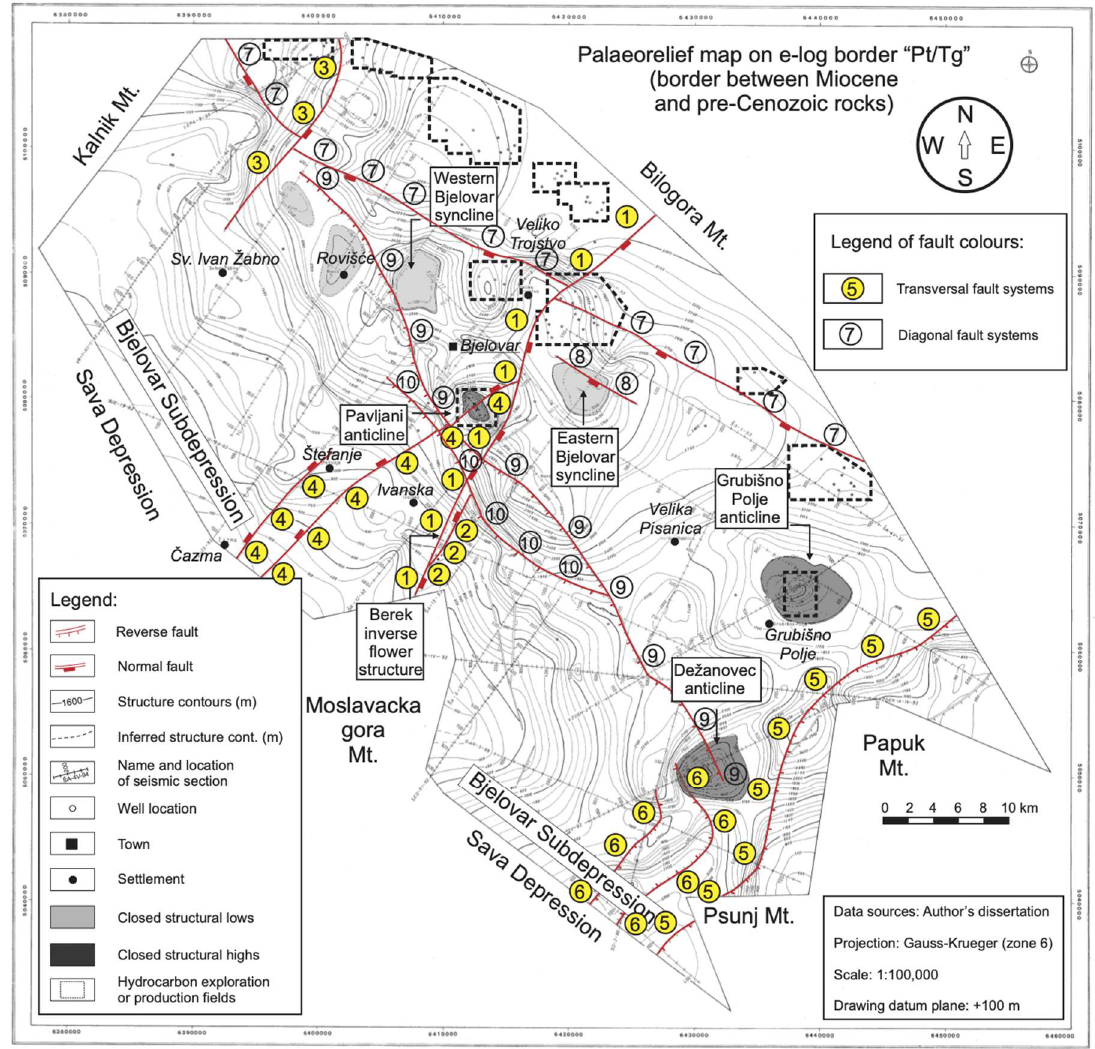
Figure 10. The main fault zones in the Bjelovar Subdepression shown on paleorelief map of the Neogene basement